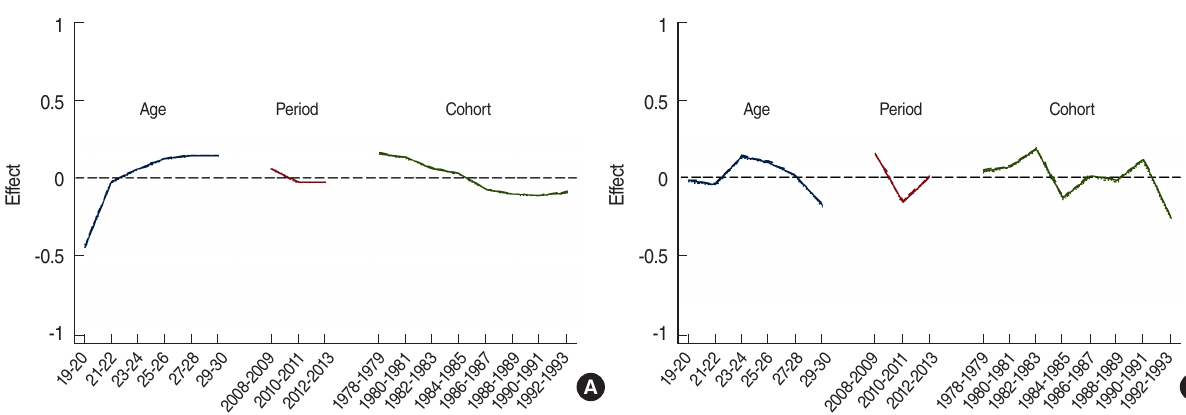
Figure 2. Age-period-cohort analysis of smoking prevalence in Korean men (A) and women